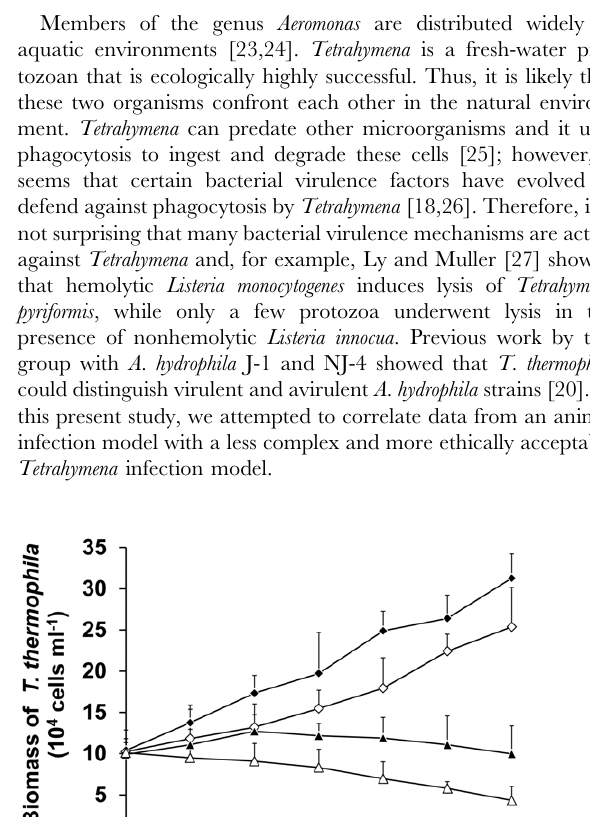
Figure 3. Relative survival of T.thermophila co-cultivated with Aeromonas strains in three different proportions. Relative survival of T. thermophila at 12 h is expressed as the number of T. thermophila cells in the co-culture with Aeromonas spp. relative to the number of T. thermophila cells cultured alone. At the beginning of the experiment, T. thermophila was at 2 6 10 5 cells/ml while the Aeromonas spp. was at 2.0 6 10 8 CFU/ml (A), 1.0 6 10 9 CFU/ml (B) and 1.5 6 10 9 CFU/ml (C), respectively. Error bars represent SDs from a minimum of three independent experiments, with each experiment being comprised of six individual measurements.